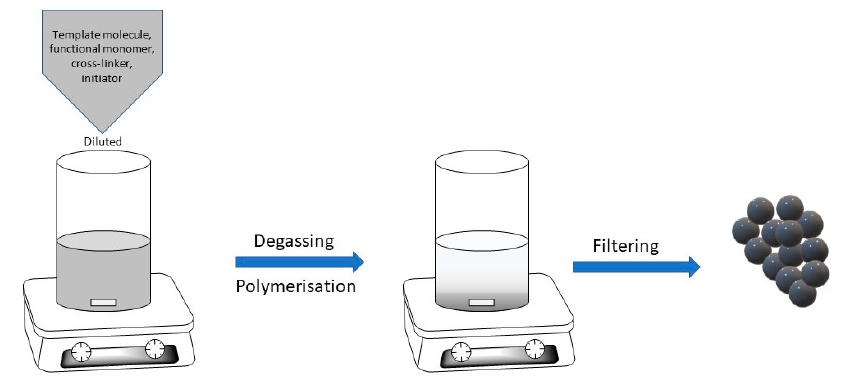
Figure 3. General synthetic scheme for polymerization.